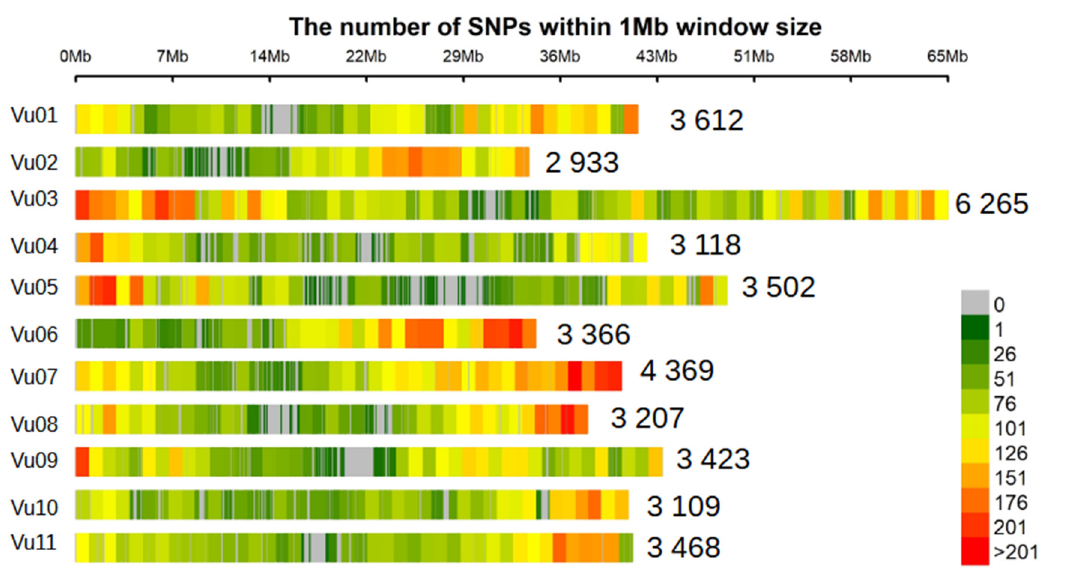
Figure 3. SNP distributions on 11 chromosomes of cowpea. A heat map is presented showing chromosomal regions with high number of SNP within 1 Mb window size. The horizontal axis displays the chromosome length. Legend (0–201) insert indicates the SNP density; on top of each chromosome there is an insert reflecting the total number of SNPs per chromosome.